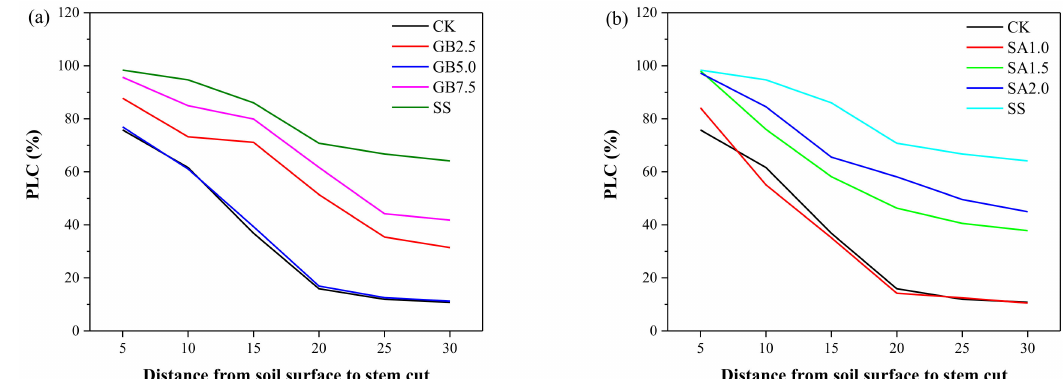
Figure 4. Effect of ( a ) exogenous glycine betaine (GB) and ( b ) salicylic acid (SA) on the percentage loss of conductivity (PLC) under the 150 mM NaCl regime. Treatments: CK, control; GB2.5, 2.5 mM GB; GB5.0, 5.0 mM GB; GB7.5, 7.5 mM GB; SA1.0, 1.0 mM SA; SA1.5, 1.5 mM SA; SA2.0, 2.0 mM SA; SS, salt stress (150 mM) without supplementation.